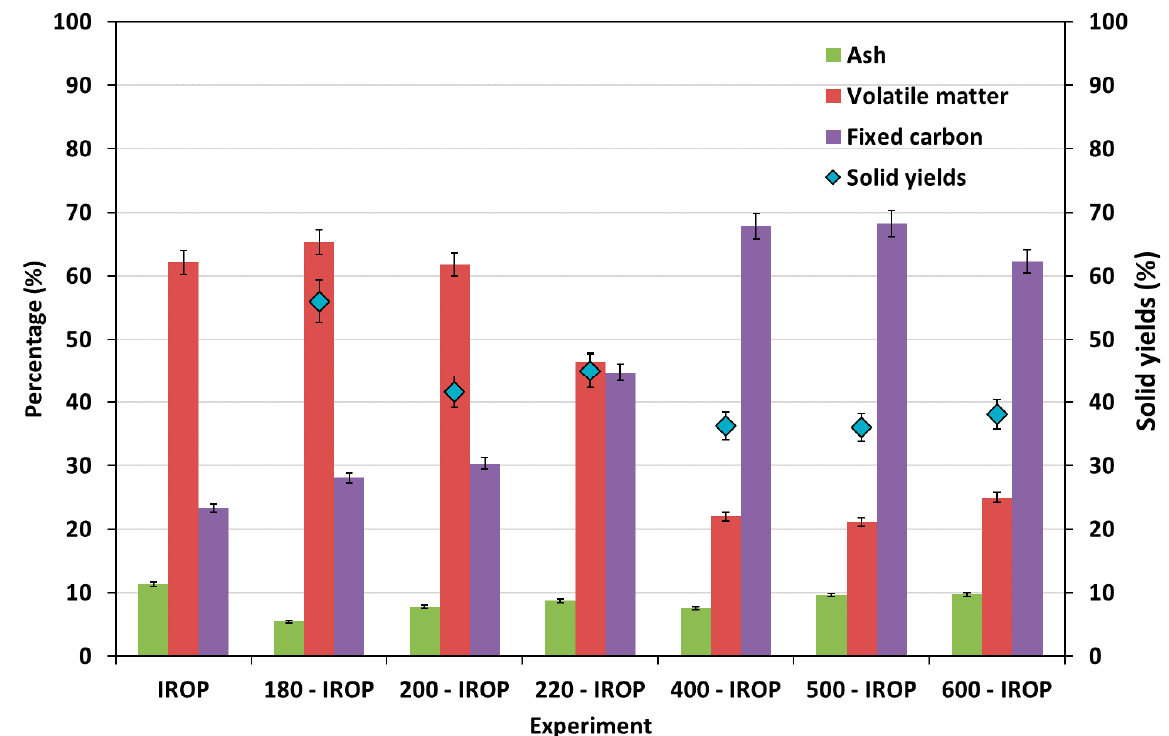
Figure 1. Solid production yields and proximate analyses of hydrochars and biochars produced from impregnated IROP under different temperatures and processes .